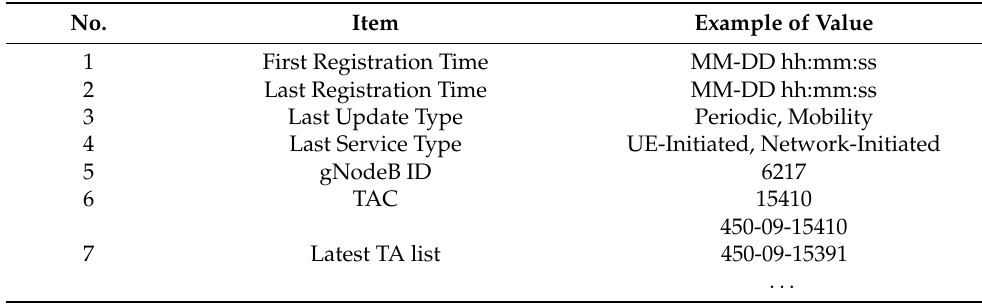
Table 2. UE profiled dataset.